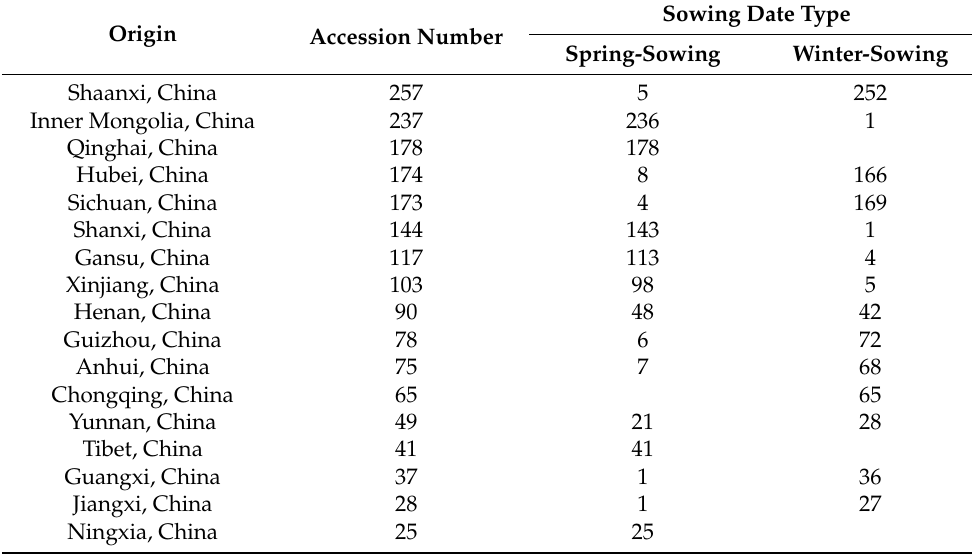
Table 1. Origin and sowing date type of 2358 pea